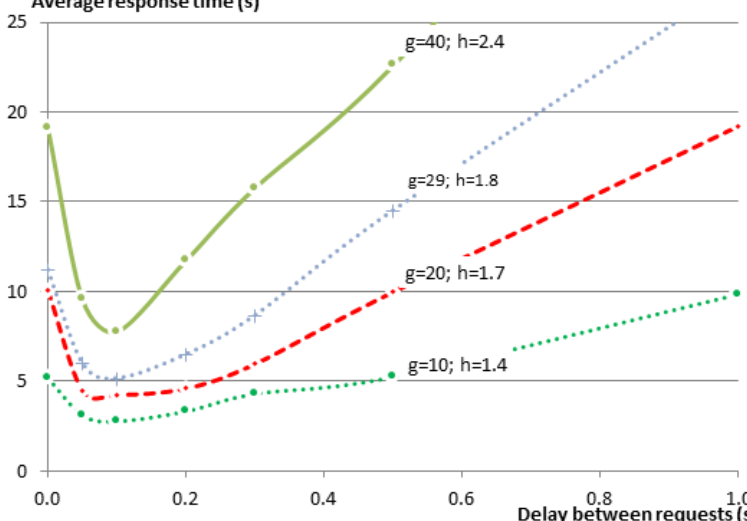
Figure 8. Entity response time for different group sizes as a function of the delay between individual requests, evaluated using the testbed.